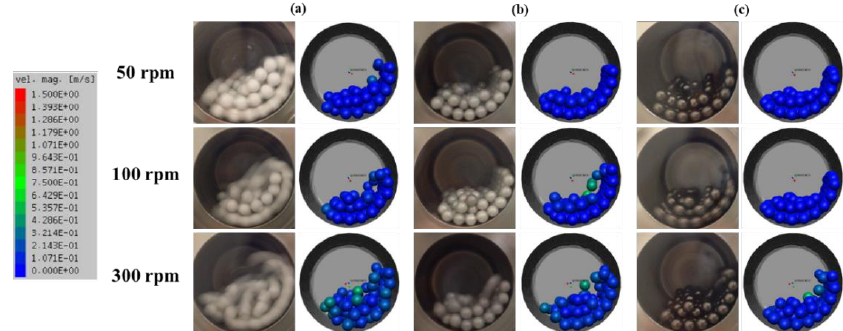
Figure 13. Simulation and actual snapshot photograph of the media motion by DEM simulation ( a )